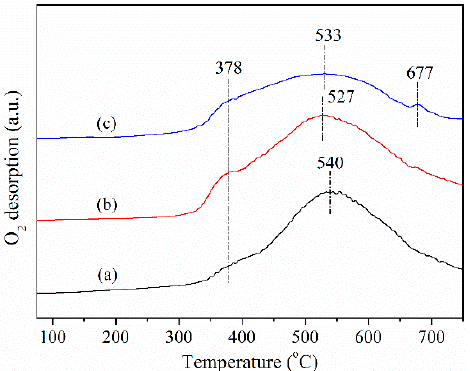
Figure 5. O 2 -TPD images of (a) 0.005BiOCl/MnMgAlO, (b) 0.01BiOCl/MnMgAlO and (c) 0.015BiOCl/MnMgAlO .